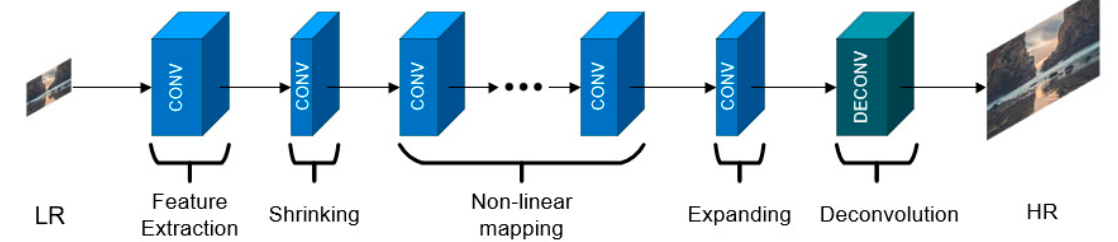
Figure 3. FSRCNN network structure.